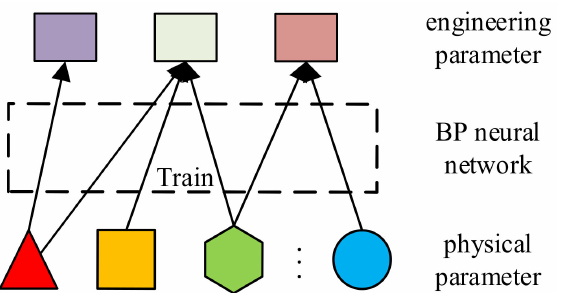
Figure 1. Mapping relationship between physical parameters and engineering parameters.